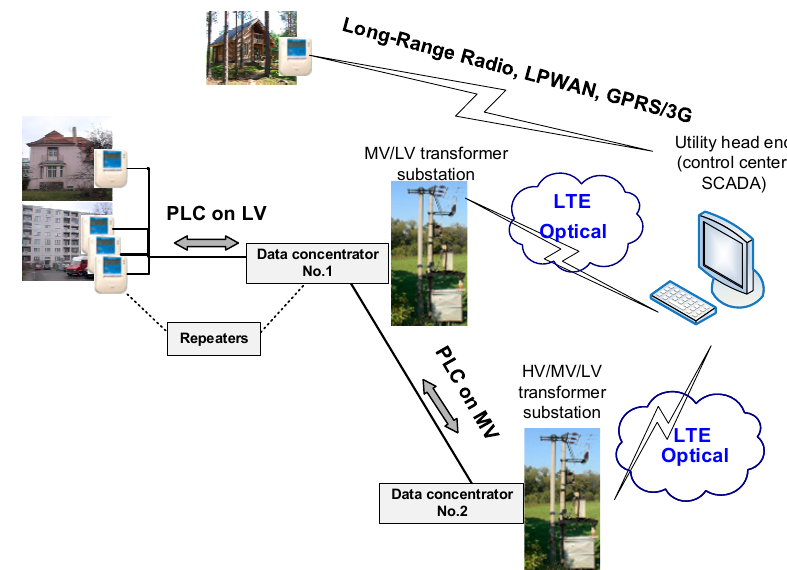
Figure 2. Smart Metering communication network architecture with major technologies used for pilots, future deployments, or roll-outs in Europe.